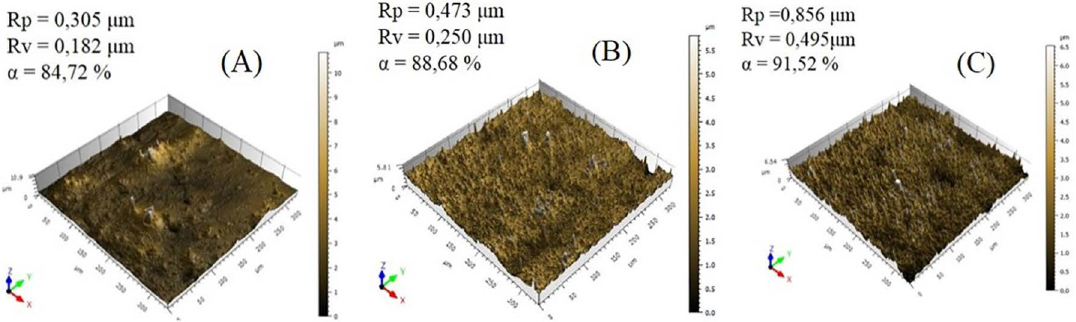
Figure 5. Profilometry of the surface of the films 1(a), 2(b) and 3(c).